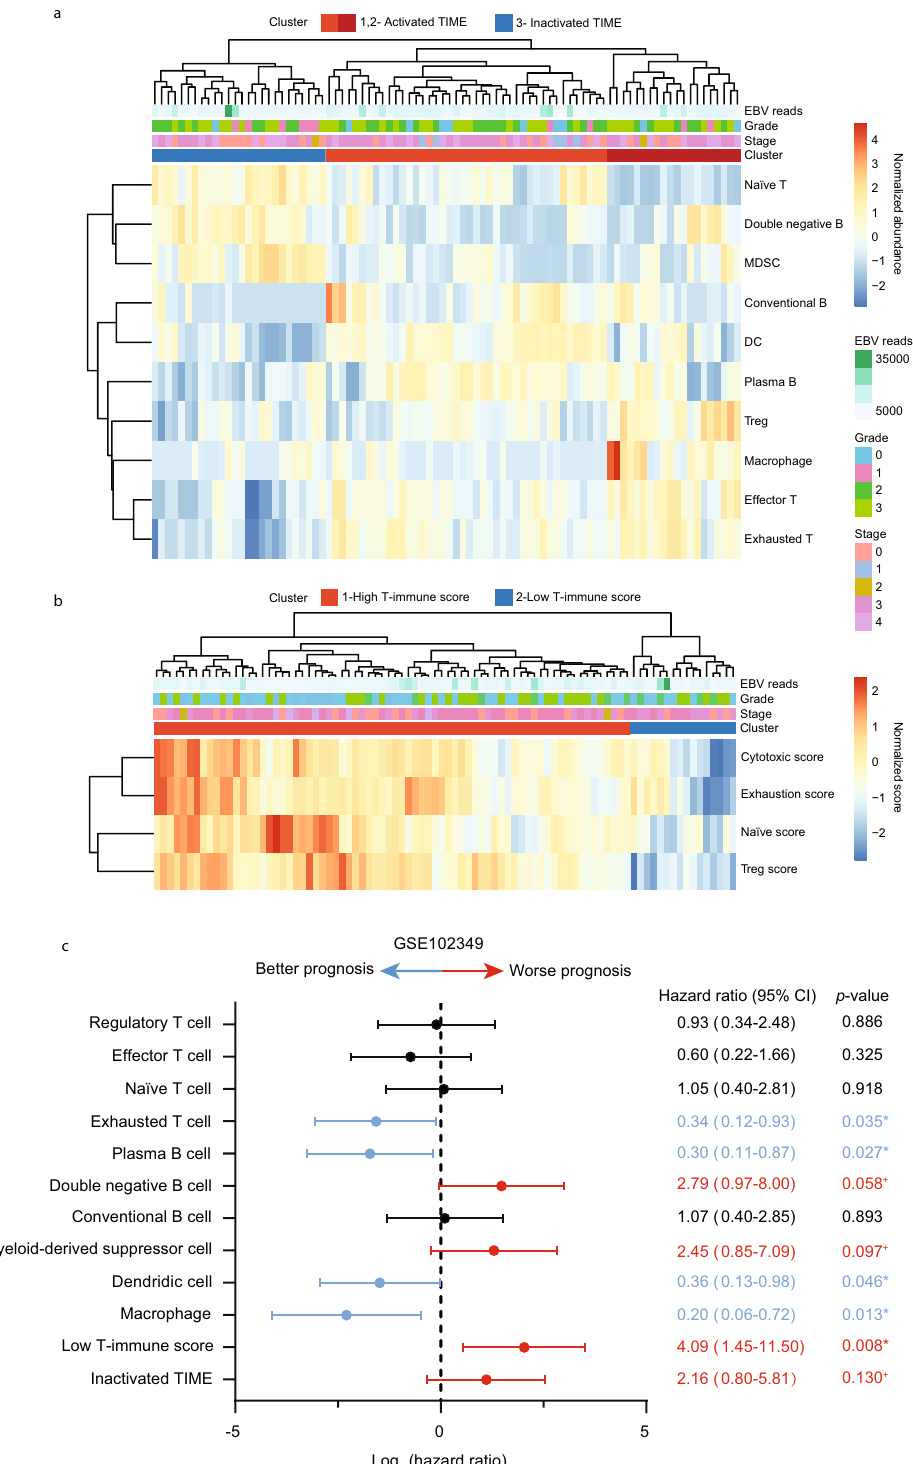
Fig. 8 Deconvolution analysis and functional modules reveal dynamic immune signatures that are associated with patient prognosis. a Heatmap of the normalized immune abundance and clinical parameters in 88 NPC patients estimated by CIBERSORTx. Patients were clustered into three groups, representing those with activated TIME (cluster 1 and 2) or inactivated TIME (cluster 3). b Heatmap of the normalized functional scores and clinical parameters in 88 NPC patients calculated by our linear model. Patients were clustered into two groups, representing those with high T-immune score (cluster) or low T-immune score (cluster 2). c The correlation between estimated subpopulations, patient clusters and progression-free survival in 88 NPC patients. The log 2 hazard ratio and the associated p- value was evaluated by the Cox proportional hazards model with 95% CI. p values ≤ 0.05 were considered statistically signi fi cant in prognosis, whereas p value > 0.05 and ≤ 0.15 were considered marginally signi fi cant in prognosis and represented as + . Source data are provided as a Source Data fi